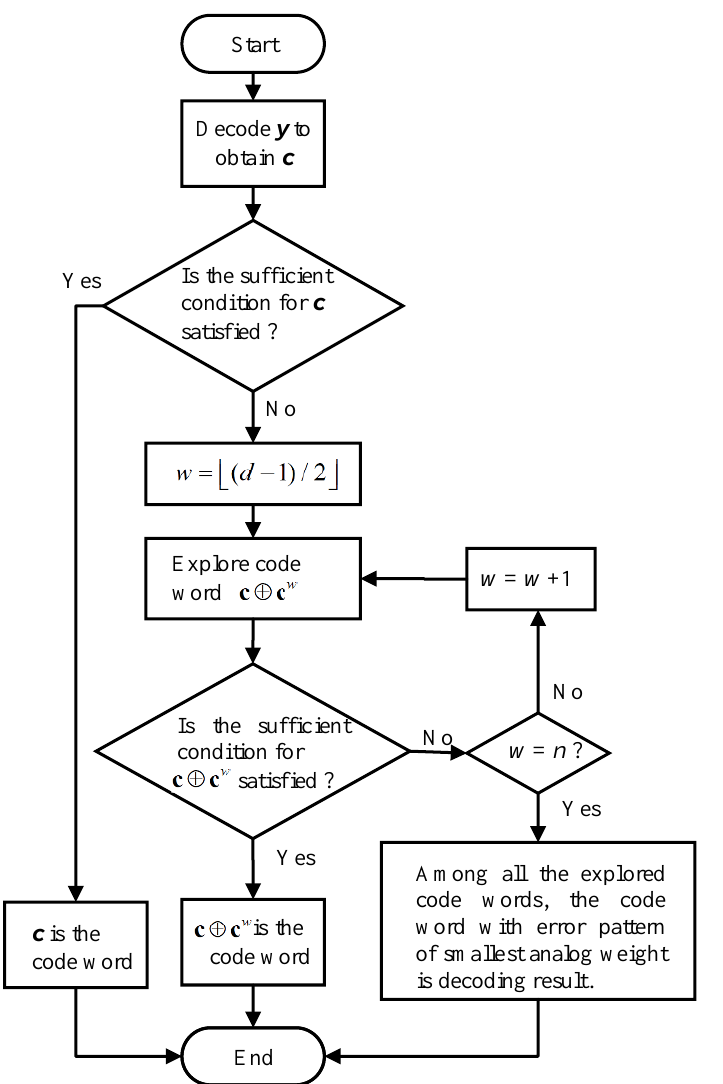
Figure 1. The flowchart of the